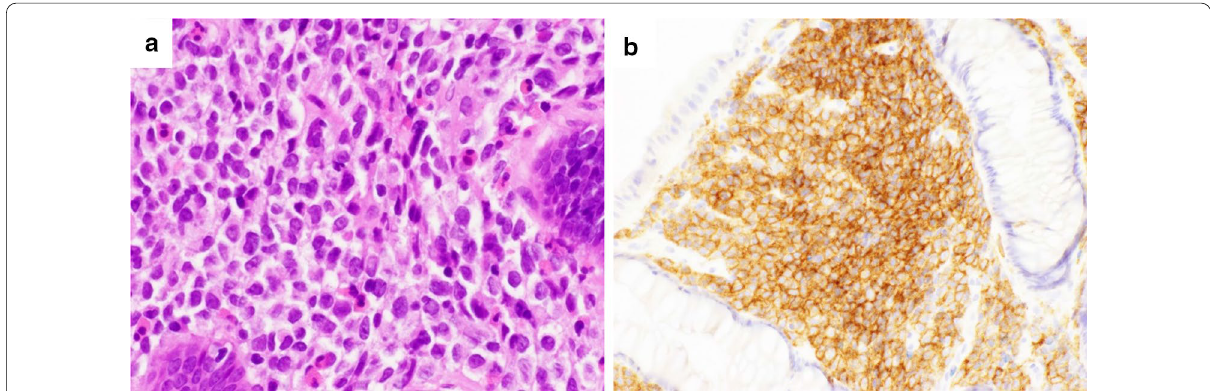
Fig. 4 a Hematoxylin staining shows atypical cells with irregular karyotype and prominent nucleoli. b Immunohistochemical staining of CD33